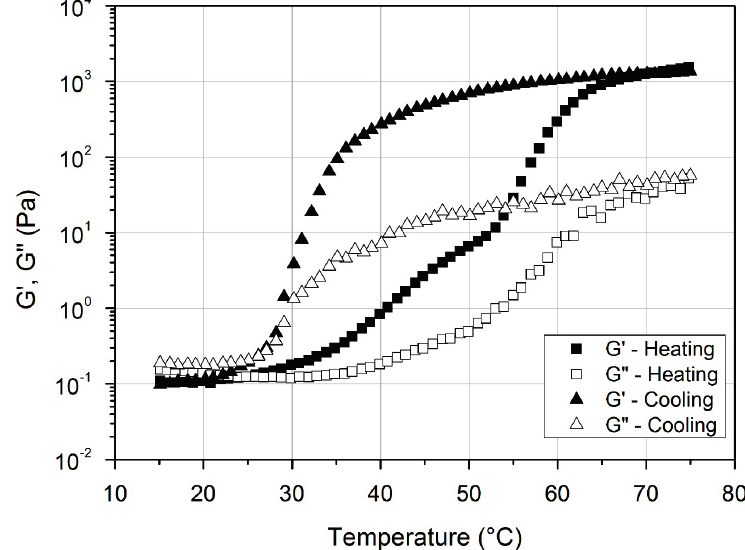
Figure 8. Temperature dependence of dynamic viscoelasticities for methylcellulose A4M at 10 g/L in aqueous solution. Constant frenquency of 0.5 Hz, strain of 1% and temperature rate of 0.5 °C/min. ■ , □ heating; ▲ , Δ cooling. G ' full symbols and G '' open symbols. Reproduced with permission from Taylor & Francis Group, 2015